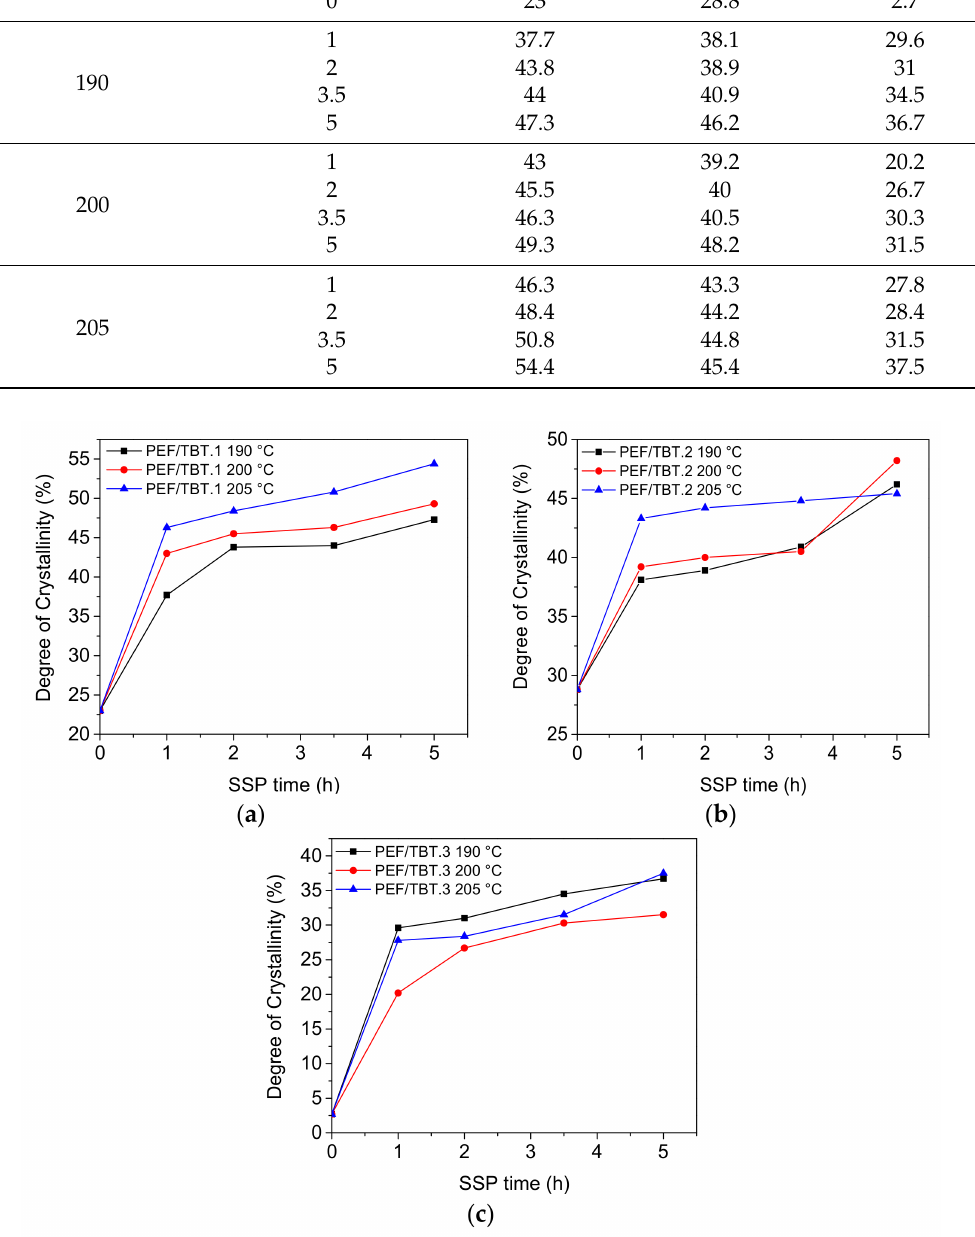
Figure 6. Effect of SSP time and temperature on the evolution of the degree of crystallinity of PEF samples: ( a ) PEF/TBT.1, ( b ) PEF/TBT.2, ( c )